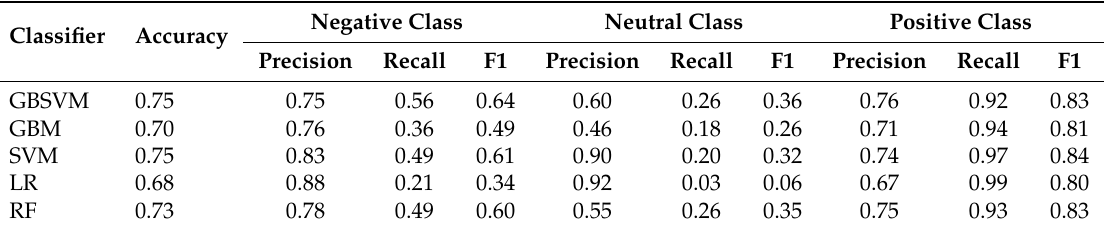
Table 5. Accuracy of classifiers using TF-IDF (Bi-gram) features.